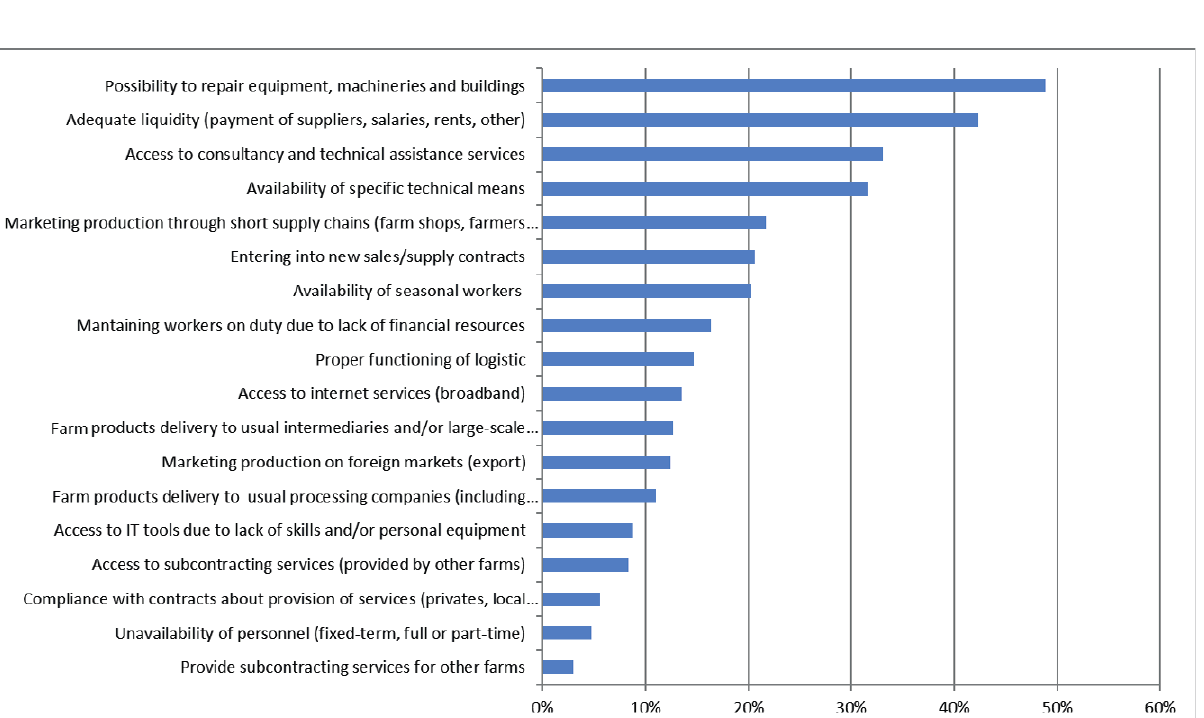
Figure 4. Diffi culties faced by surveyed farms during the lockdown (%). Source: own elaboration on collected